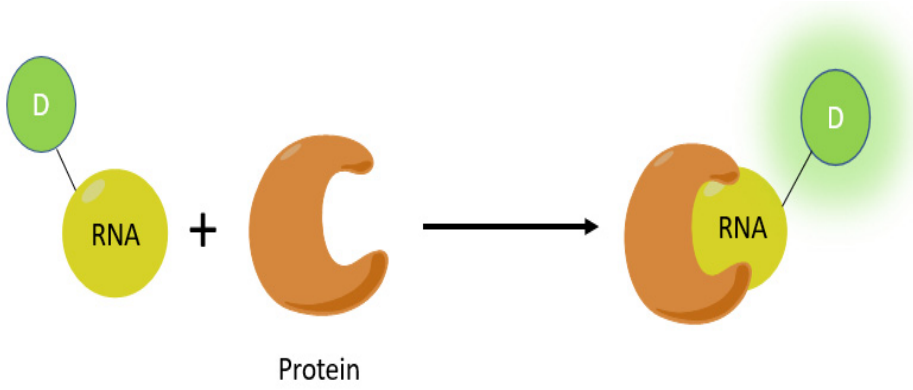
Figure 10. Schematic illustration of PIFE. Strong fluorescence would be observed only if the RNA binds with the target protein.